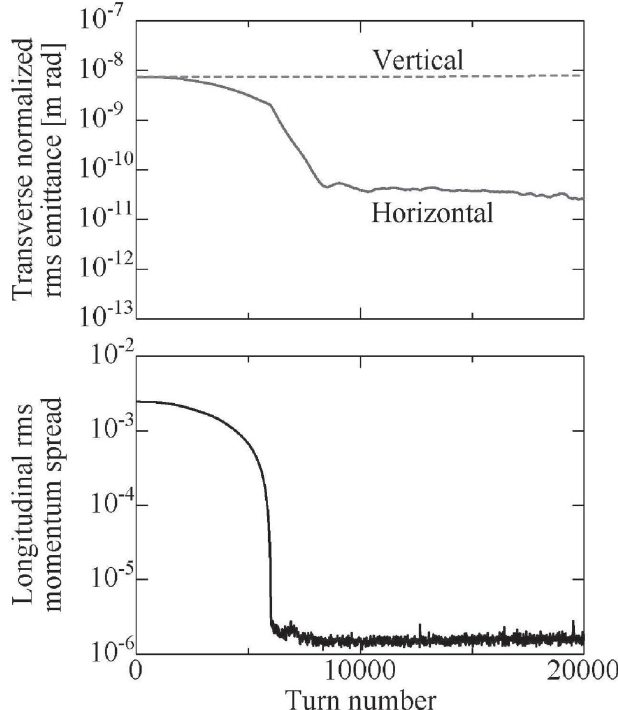
FIG. 15. Time evolutions of the transverse normalized rms emittances and longitudinal rms momentum spread of a 35 keV 24 Mg (cid:4) beam cooled with two counterpropagating lasers. Both lasers have been horizontally displaced by (cid:5)x (cid:2) 3 mm . The line density of the beam is 4 : 8 (cid:9) 10 3 m (cid:1) 1 , and the bare (cid:5) (cid:2) (cid:3) 1 : 60 ; 1 : 80 (cid:5) in this simulation. The ; (cid:4) betatron tunes are (cid:3) (cid:4) x y final detuning after a laser-frequency scan completed at 6000th (cid:2) (cid:1) 75 MHz in the beam rest turn is (cid:3) 0